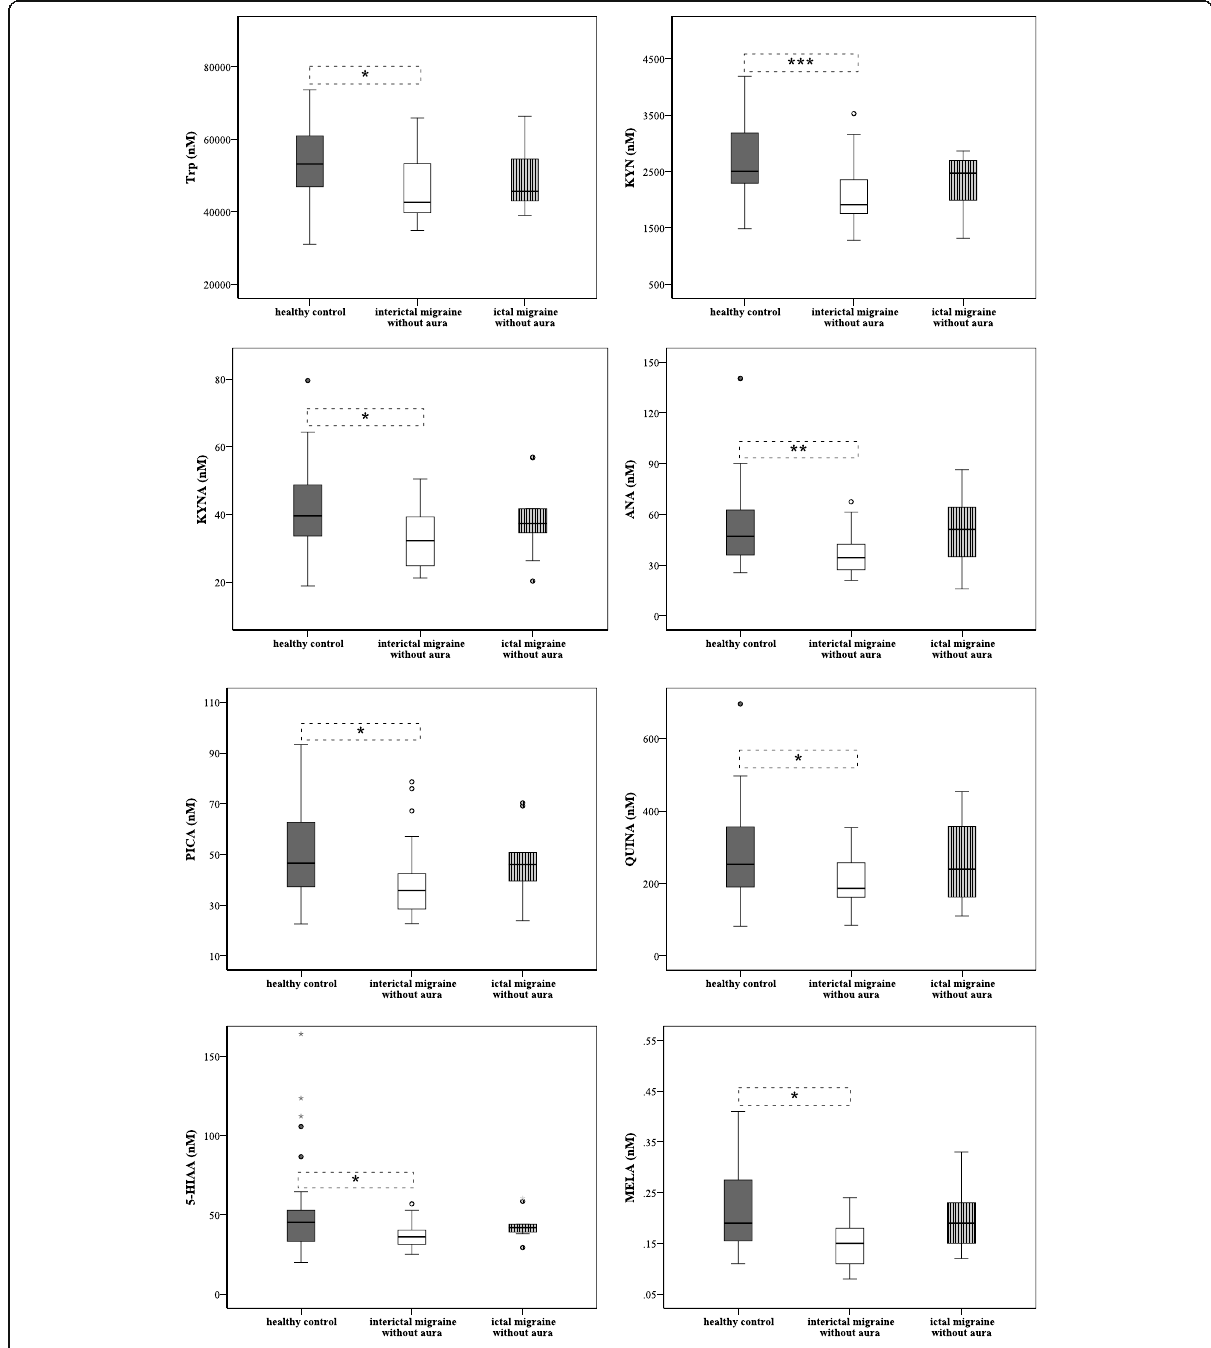
Fig. 3 Differences in plasma levels of Trp, KYN, KYNA, ANA, PICA, QUINA, 5-HIAA and MELA between groups of interictal/ictal phases of migraine without aura patients and healthy subjects (median, interquartile range, minimum, maximum values and outliers were presented in this figure). Sample sizes in groups: healthy control (n = 34), interictal phase of MWoA (n = 28), ictal phase of MWoA (n = 10). Sample sizes in case of MELA: healthy control (n = 30), interictal phase of MWoA ( n = 22), ictal phase of MWoA (n = 9). Significance levels: * p < 0.05, ** p < 0.01, *** p < 0.001. Trp: Tryptophan, KYN: L-kynurenine, KYNA: Kynurenic acid, ANA: Anthranilic acid, PICA: Picolinic acid, QUINA: Quinolinic acid, 5-HIAA: 5-hydroxy- indoleaceticacid, MELA: